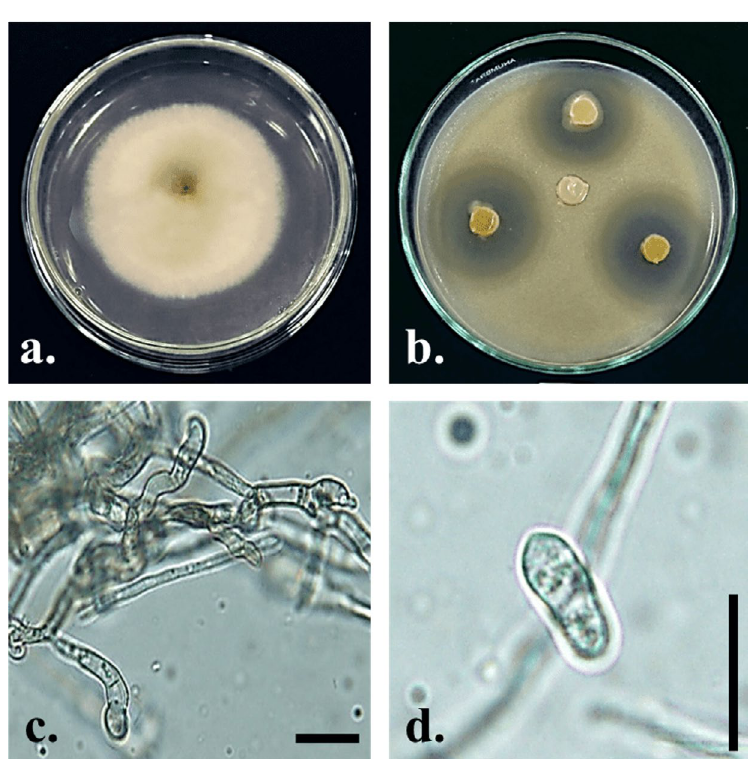
Fig. 2. Colletotrichum siamense Gp07. Upper (a) side of culture on PDA 7 days after inoculation; (b) antagonistic activity against S. aureus ATCC 29213 on PDA + 1% yeast extract (w/v) 2 days after incubation; (c) conidiogenous cell; (d) conidia; Bars = 10 µm.